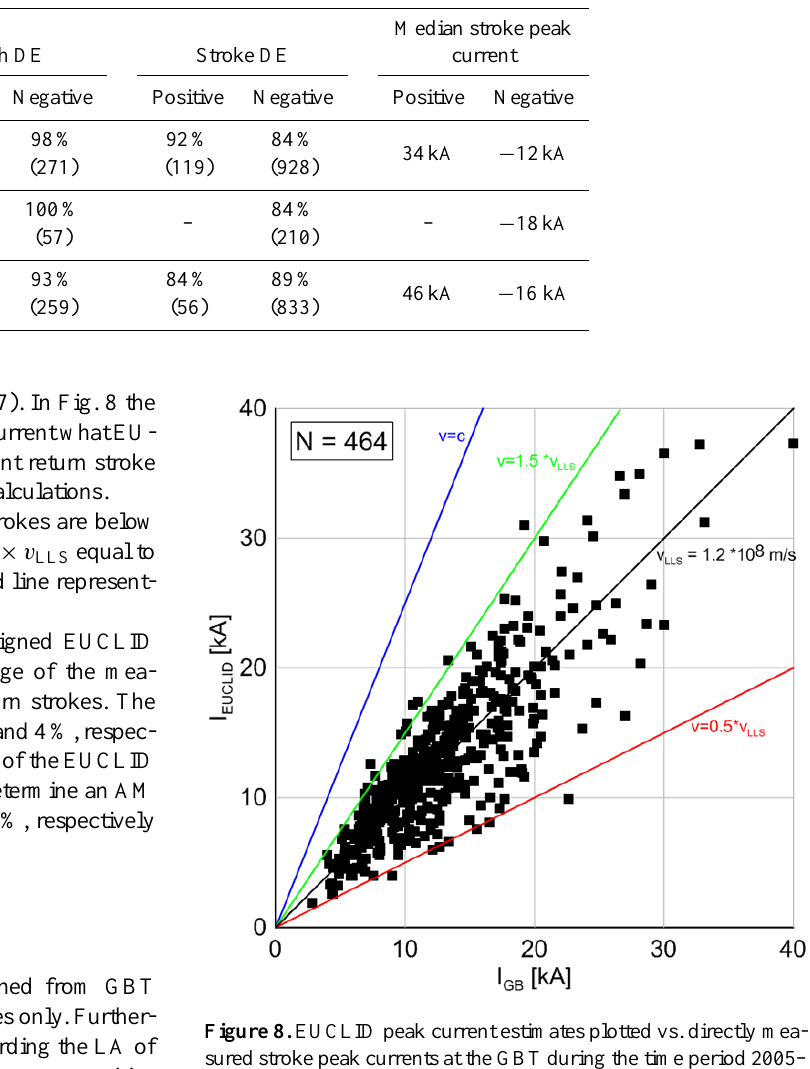
Table 3. Flash and stroke DEs determined from VFRS data. The number of flashes/strokes recorded during each of the campaigns is given in the parenthesis. Median peak current is given for strokes used in this analysis.